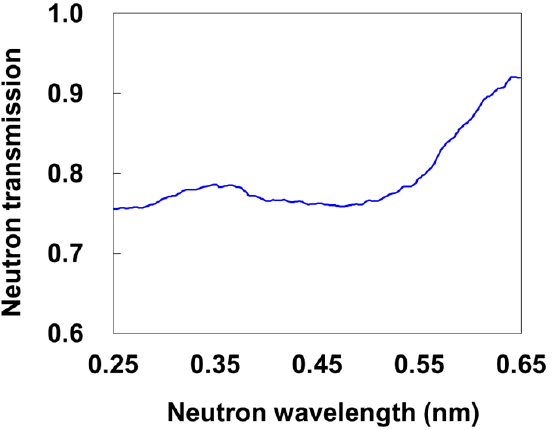
Figure 9. Neutron transmission spectrum of LBE melt obtained by integrating the 100% liquid-phase zone from the TOF imaging